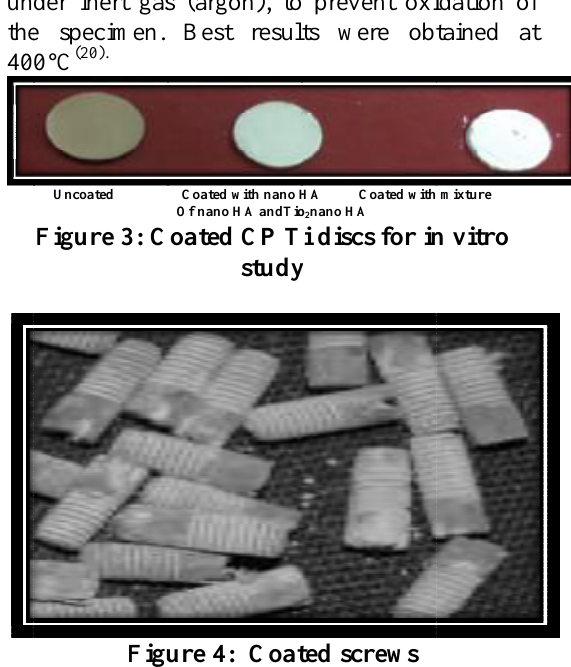
Sterilization of screws